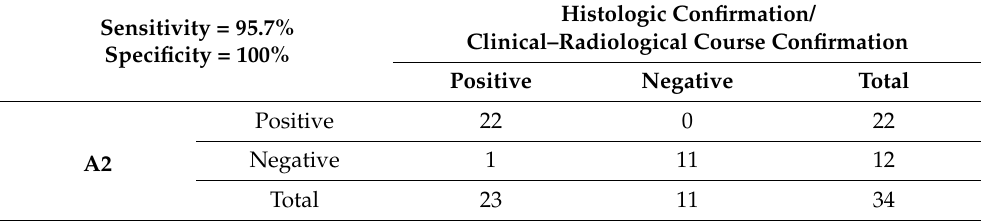
Table 14. Sensitivity and specificity of 68 Ga-DOTATOC-PET/CT A2 with histologic and clinical– radiological course